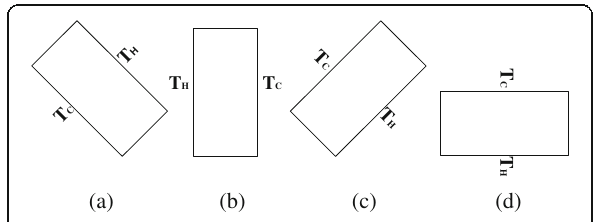
Fig. 6 Schematic diagram of rotation angles. Schematic diagram of the enclosures with four different rotation angles. a α = − 45°. b α =